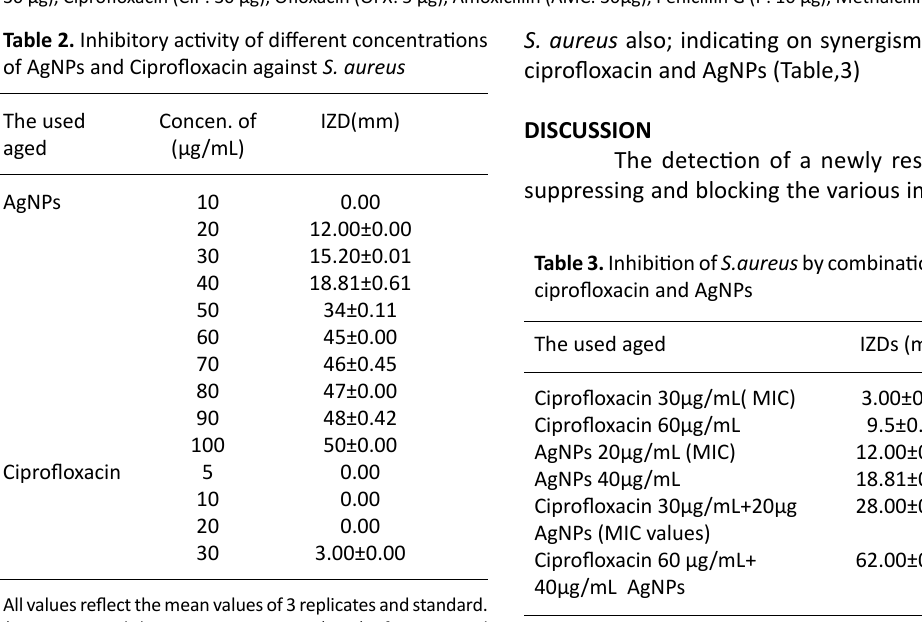
All values reflect the mean values of 3 replicates and